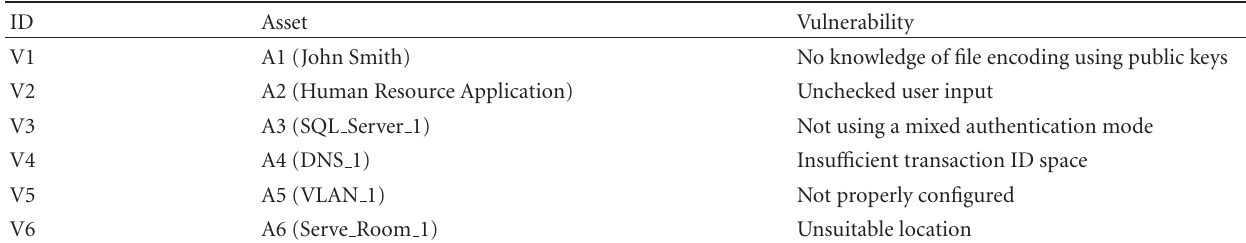
Table 9: Asset vulnerabilities.